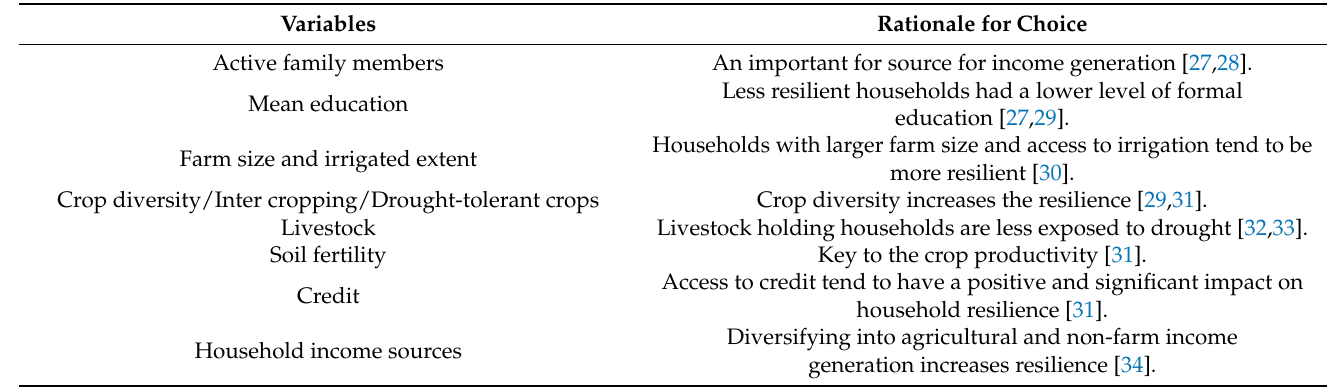
Table 1. Identification of key indicators for the